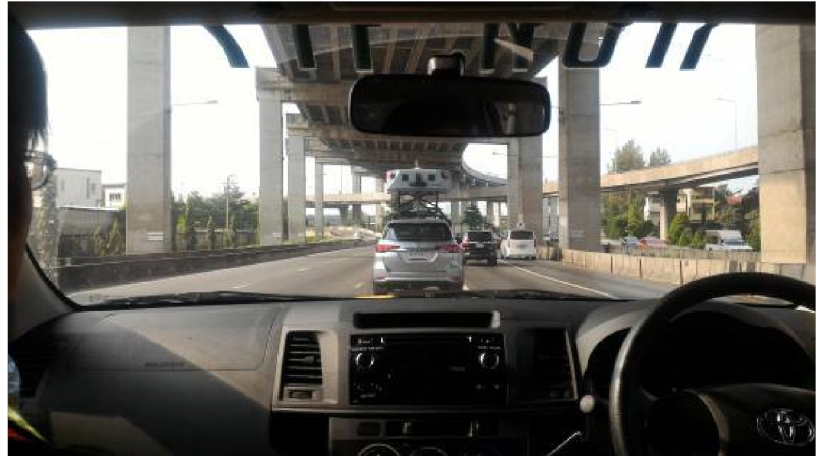
Figure 4. MLS scanning in operation.